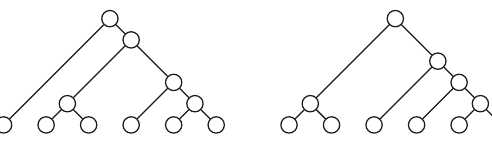
Figure 6: The tree shapes in T ∗ 6 mentioned in Remark